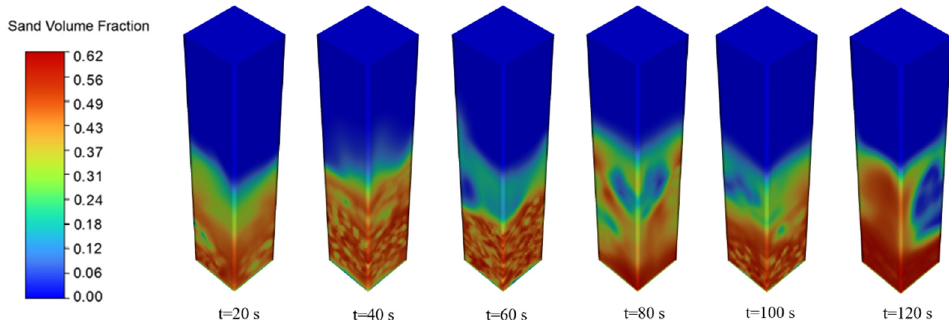
Figure 5. Contours of sand volume fraction at different times.